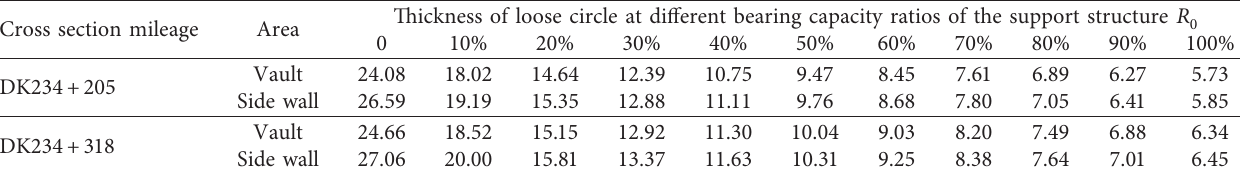
Table 6: The calculation values of loose circles of grade II and III large deformation section (m). Cross section